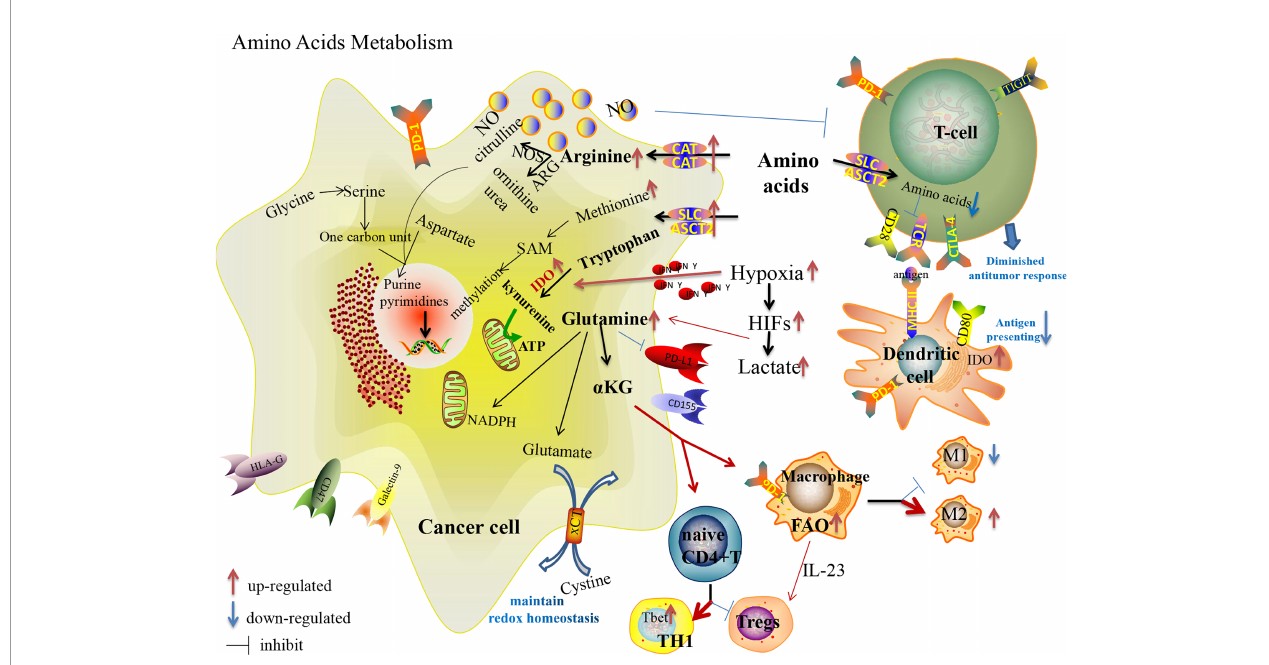
FIGURE 2 | Amino acid metabolism reprogramming in cancer cells and immune cells in the TME, and their effects on the expression of immune